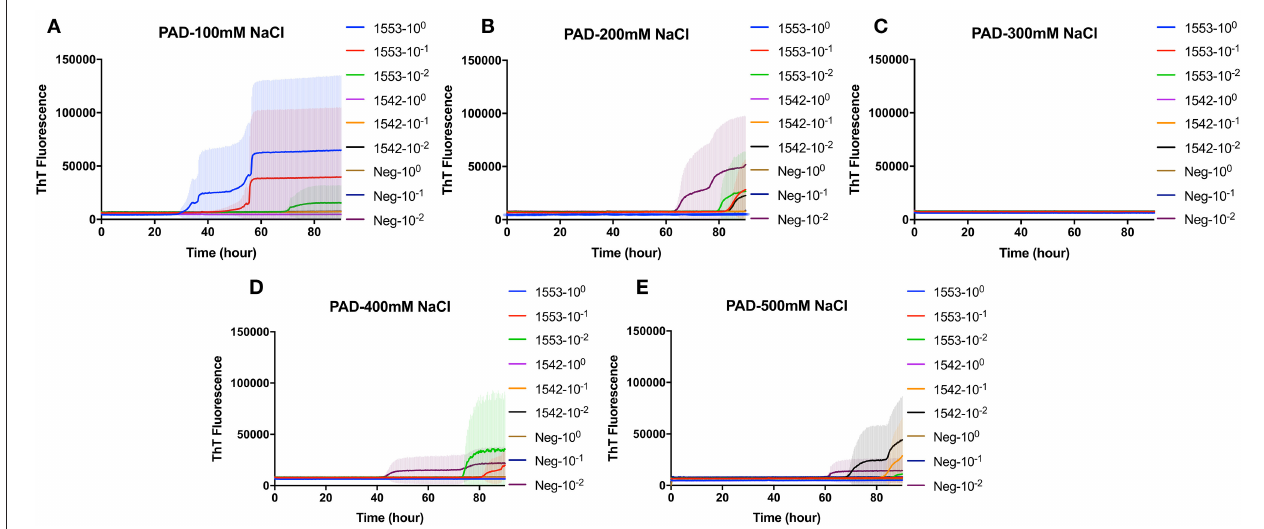
FIGURE 3 | Real-time quacking-induced conversion (RT-QuIC) reactions containing different NaCl concentrations (A) 100mM, (B) 200mM, (C) 300mM, (D) 400mM, and (E) 500mM seeded with PAD-Beads enriched fecal dilutions from CWD infected white-tailed deer brains using BV rPrP as a substrate. RT-QuIC reactions were seeded with 10 0 , 10 − 1 , or 10 − 2 dilutions of 10% fecal homogenate. All reactions were seeded with fecal homogenate of white-tailed deer with the addition of 0.001% of SDS. Shown are the average ThT fluorescence readings determined from all replicates (four replicate reactions per each